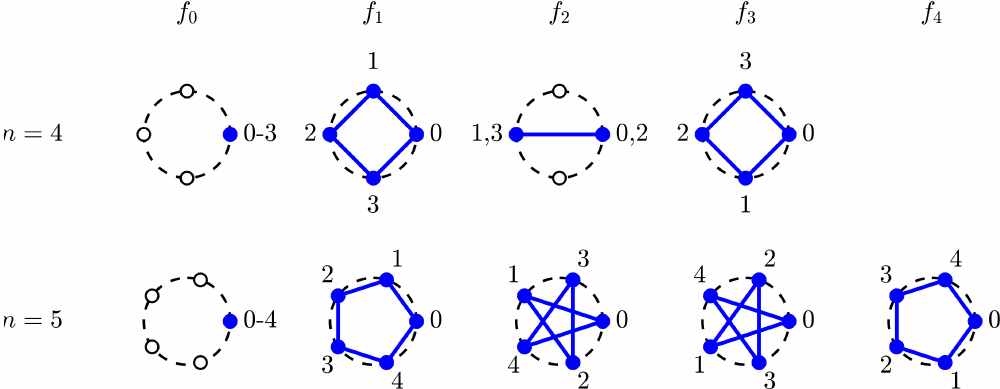
Figure 3. Fourier polygons f k (blue) for n = 4 and n = 5 with given vertex